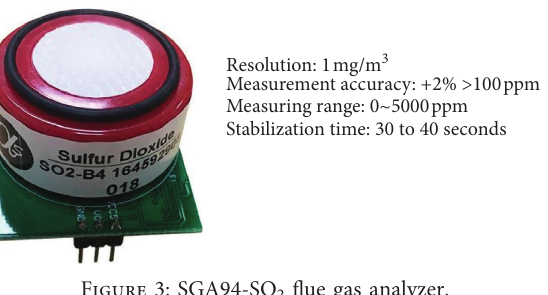
2 flue gas analyzer.